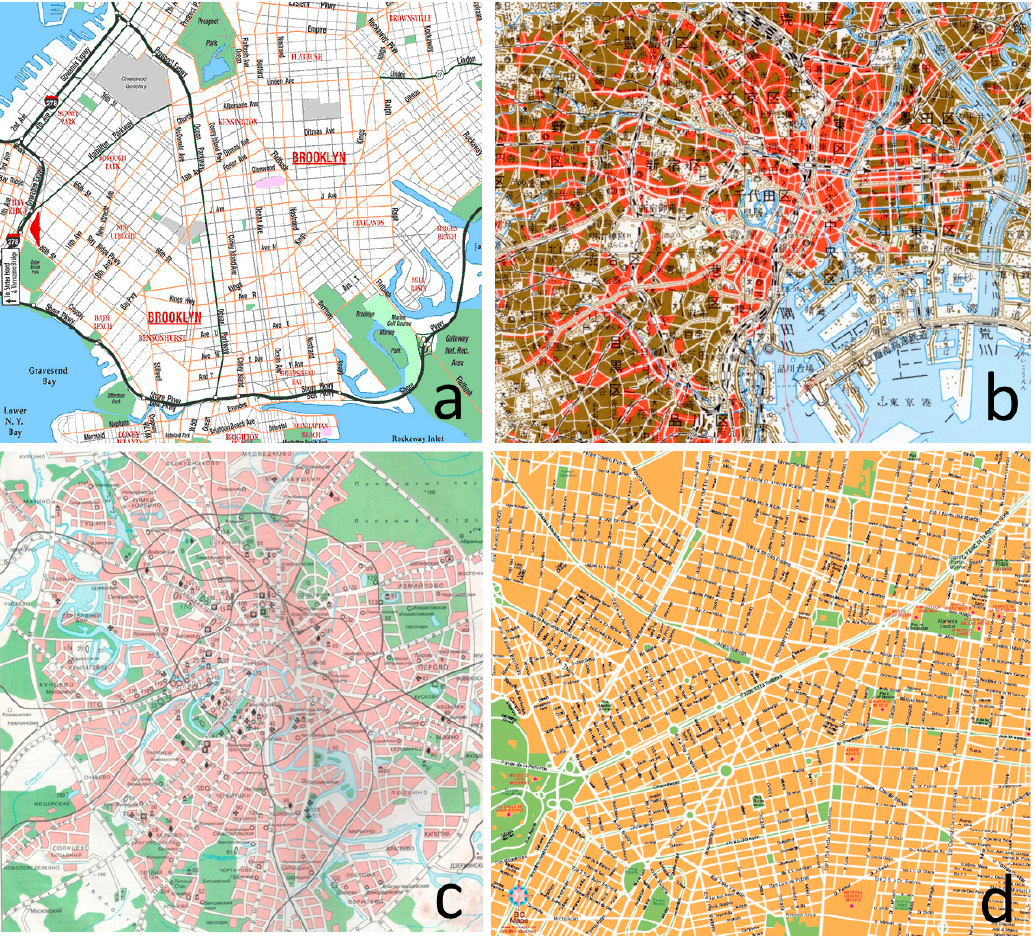
Figure 1. Traffic maps of several world conurbations ( a —New York, b —Tokyo, c —Moscow, d —Mexico).